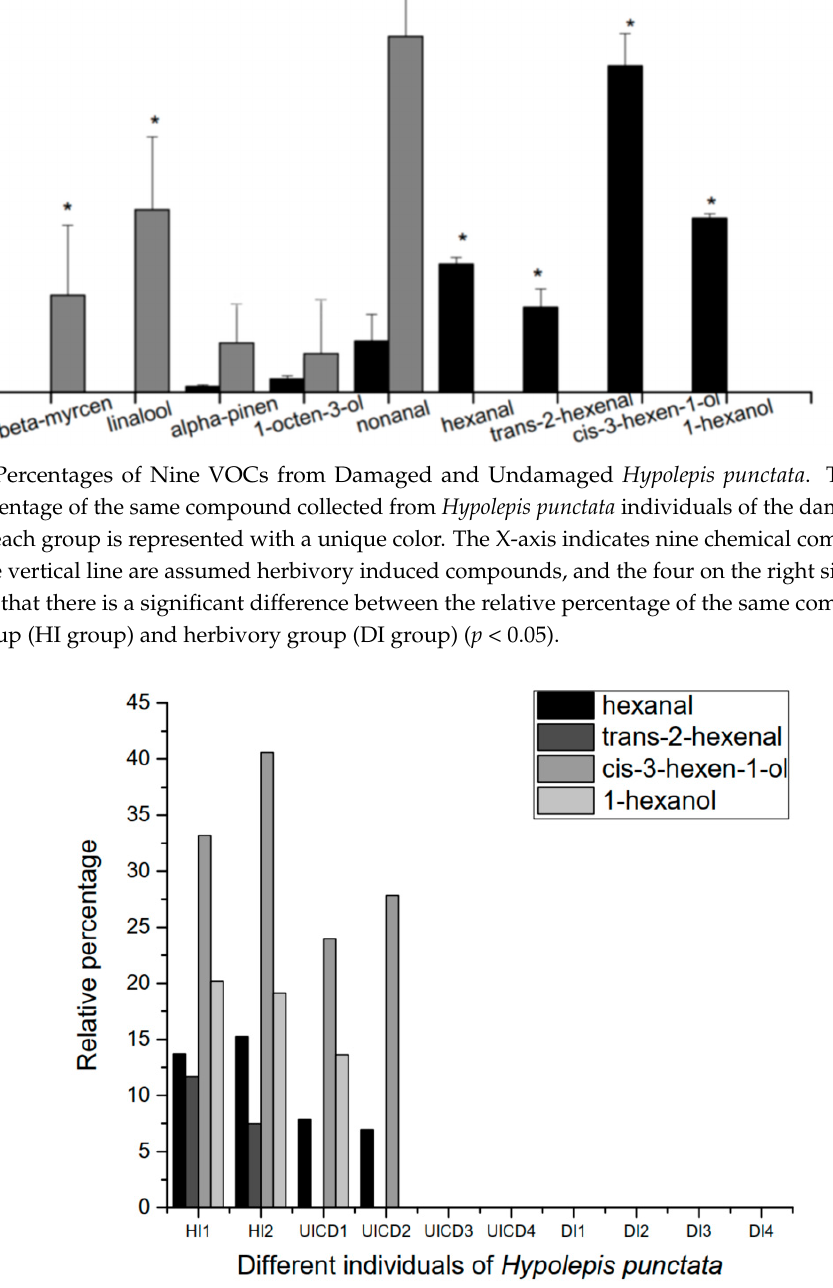
Figure 3 illustrates the relative EAG responses of the antennae taken from Sclomina erinacea to tested compounds. The antennae of both male and female S. erinacea shows the highest responses to trans-2-hexenal compared with other tested chemicals ( p < 0.05). The elicited relative EAG responses of the male antennae in descending order are trans-2- antennae removed from female insects, the EAG responses in descending order are trans- 2-hexenal, nonanal, hexanal, 1-octen-3-ol, linalool, β -myrcene, hexane, and α -pinene. All chemicals except for α -pinene and β -myrcene elicit significantly higher relative responses in both male and female antennae than hexane ( p < 0.05). Linalool, α -pinene, trans-2- hexenal, and 1-octen-3-ol elicit higher relative responses in males than in females, and response to 1-octen-3-ol is significantly different ( p < 0.05). The other three compounds elicit responses that are higher in females than in males ( p > 0.05).